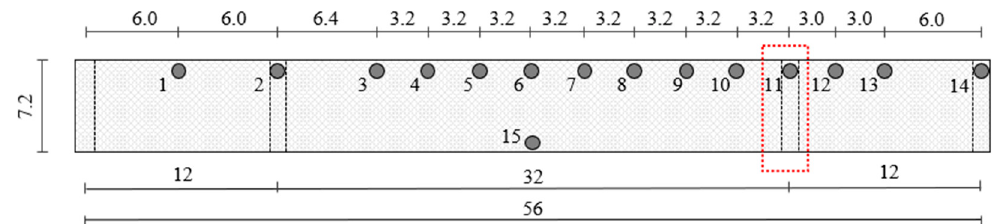
Figure 8. S101 bridge: Location of sensors [quotes in m].